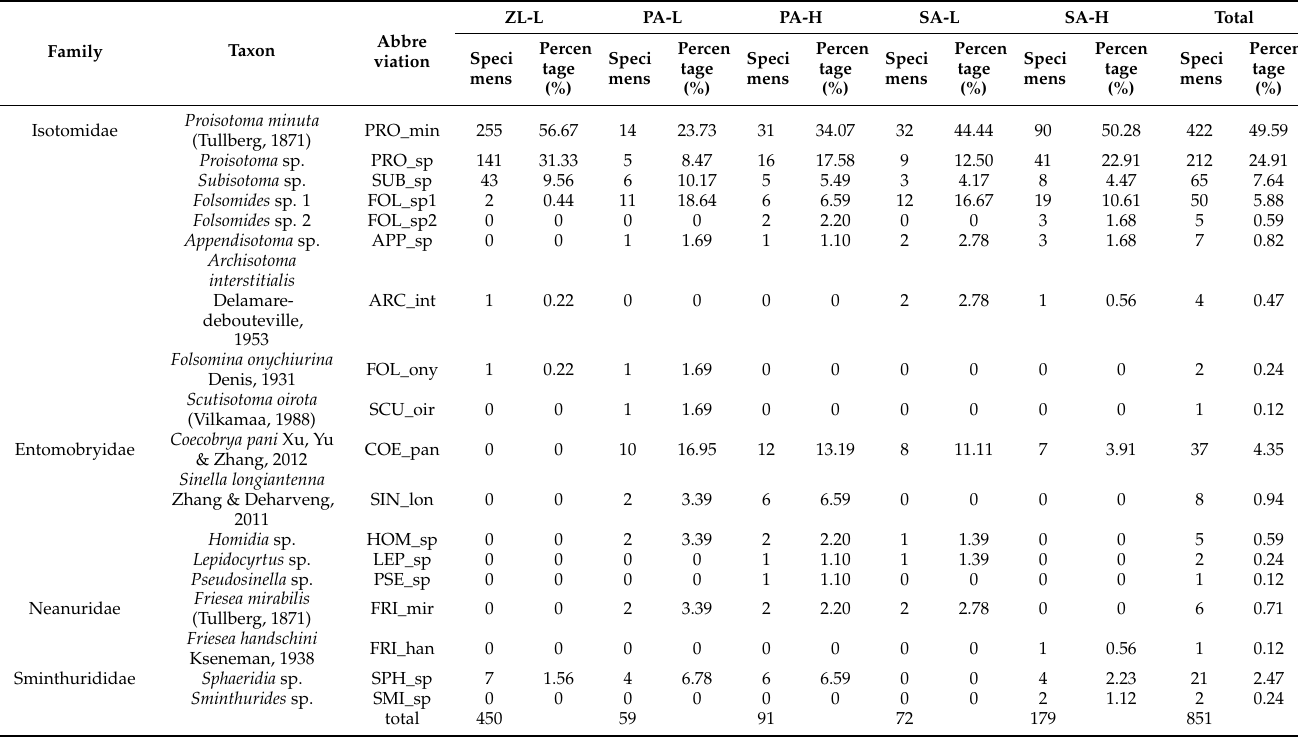
Table 4. Species composition of Collembola in the Jiuduansha